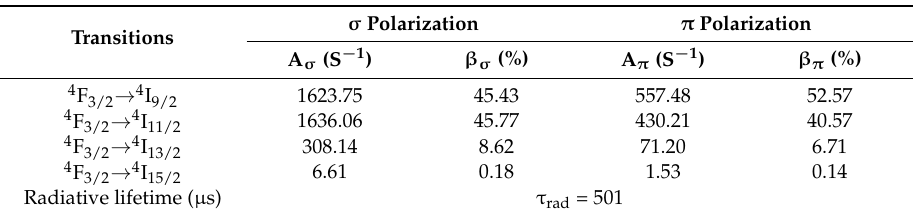
Table 3. The spontaneous transition rate, branching ratios and radiative lifetime for different transition levels of Nd:ASL